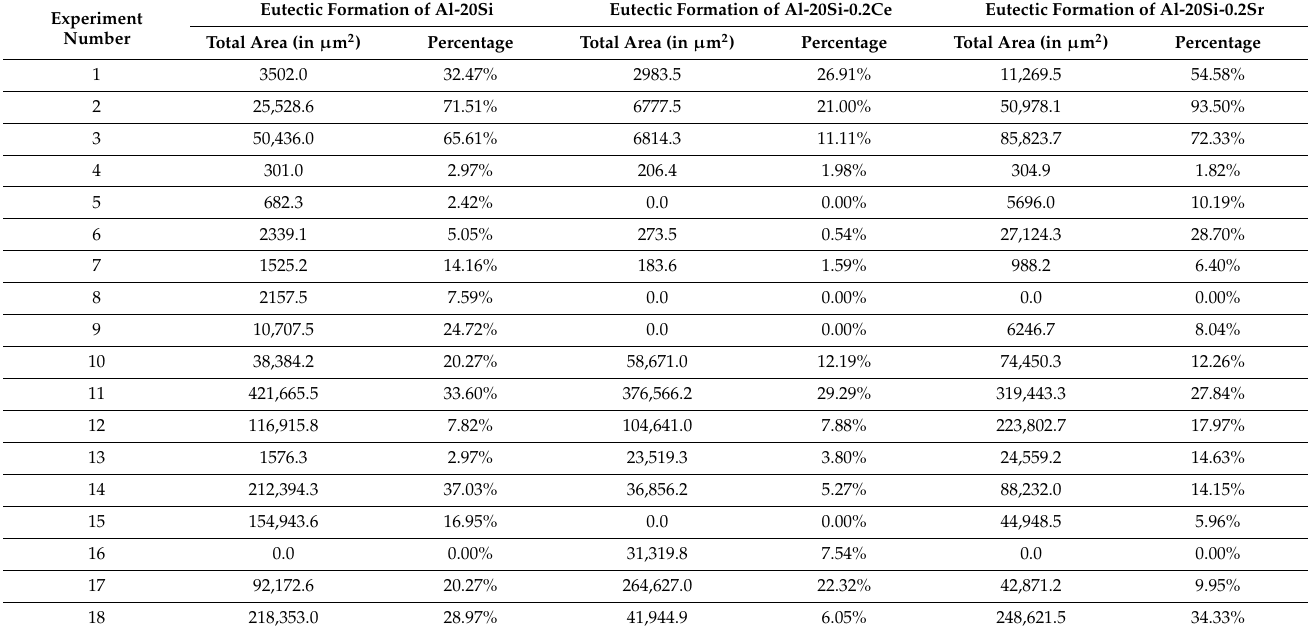
Table A2. Eutectic formation for different experiment parameters.